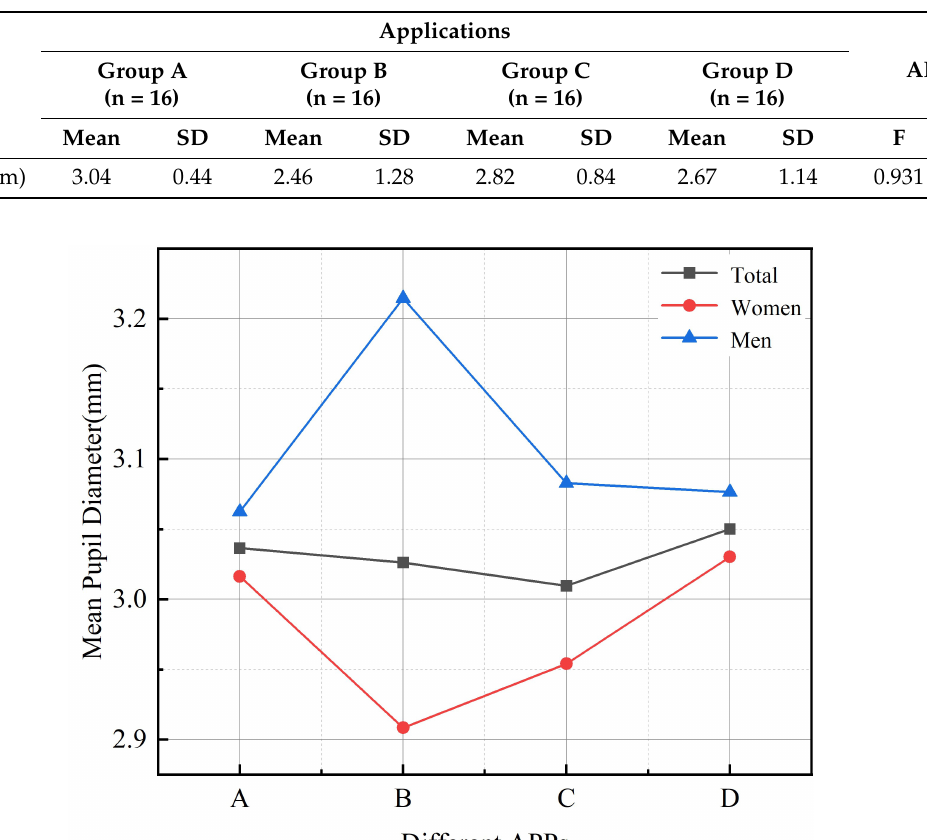
Table 4. ANOVA of participants’ mean pupil diameter for different Apps: A refers to C-life Senior Care APP; B refers to Senior Living APP; C refers to Senior Care Manager APP; D refers to Smart Aging APP.